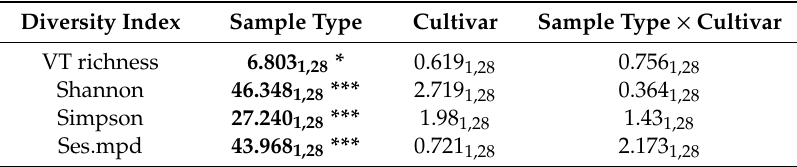
Figure 1. Boxplots showing the distribution of diversity indices by sample type. ( a ) VT richness (S). ( b ) Shannon diversity index (H). ( c ) Simpson (1-D) diversity index. ( d ) Standardized e ff ect size of mean pairwise phylogenetic distance (ses.mpd). Table 1. Linear models showing the e ff ect of sample type (soil vs. root), cultivar, and their interaction on diversity indices of the arbuscular mycorrhizal (AM) fungal communities. F values and degrees of freedom (as subscripts) are shown. Bold letters indicate significant variables: * p < 0.05; *** p <